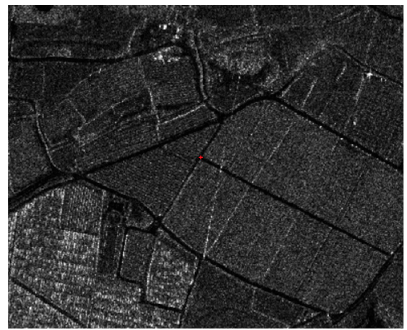
Figure 6. Schematic diagram of a PCP extracted from YG-13 SAR image in the Dengfeng area.